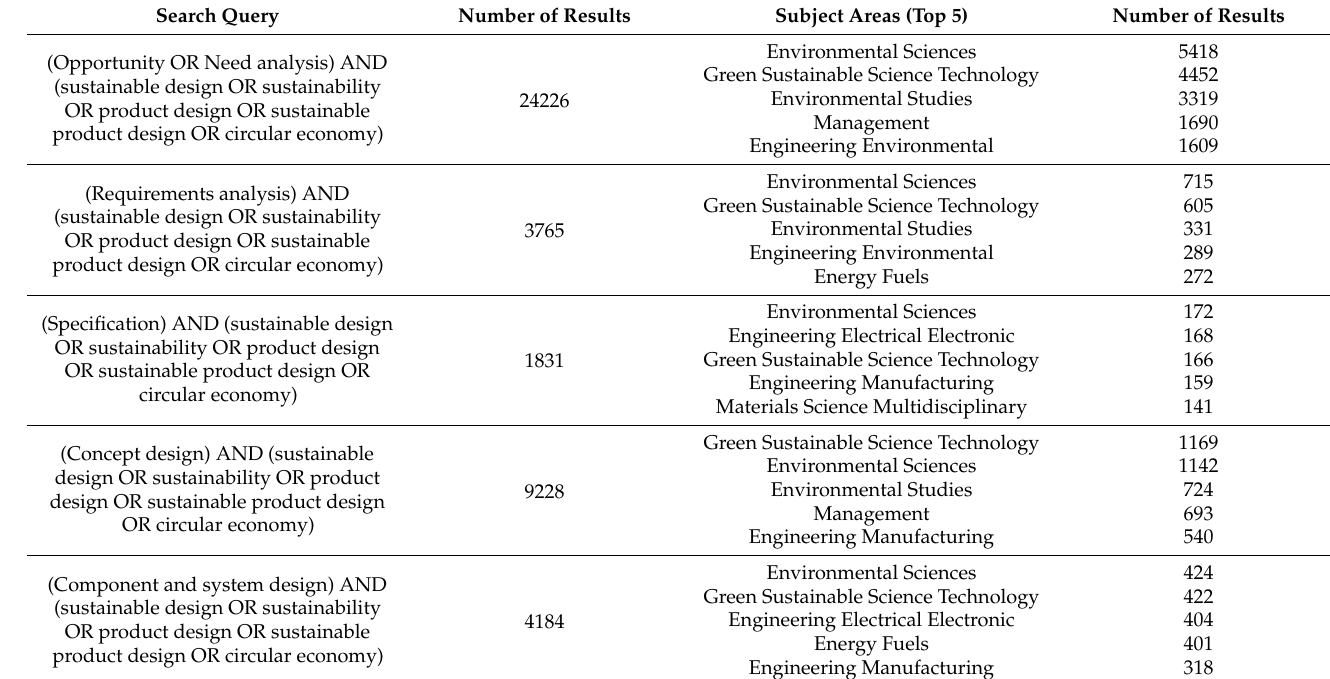
Table 3. Summary of the WoS-search results, corresponding with five key design terms from the skewed V-diagram. Search